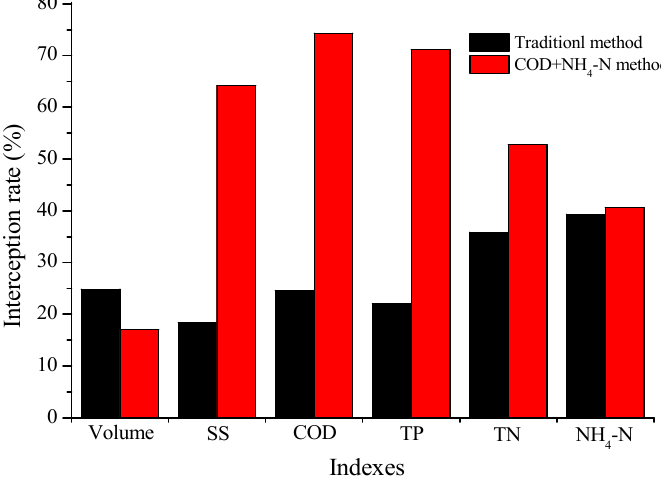
Figure 8. Comparison of interception strategy before and after optimization with the return period of five years.